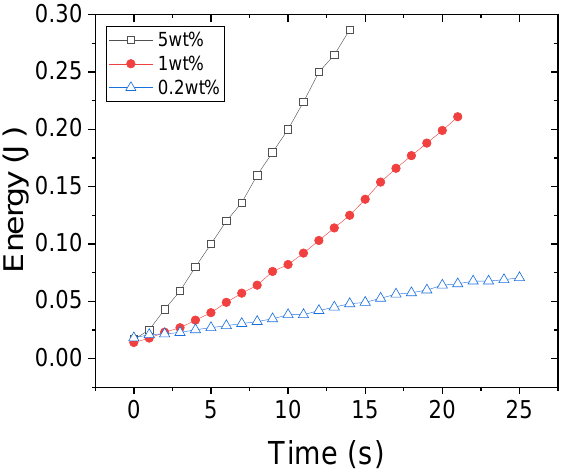
Figure 2. The energy associated with the broken hydrogen bonds due to 2.5 MHz ultrasound waves in solution concentrations of 0.2, 1, and 5 wt%.